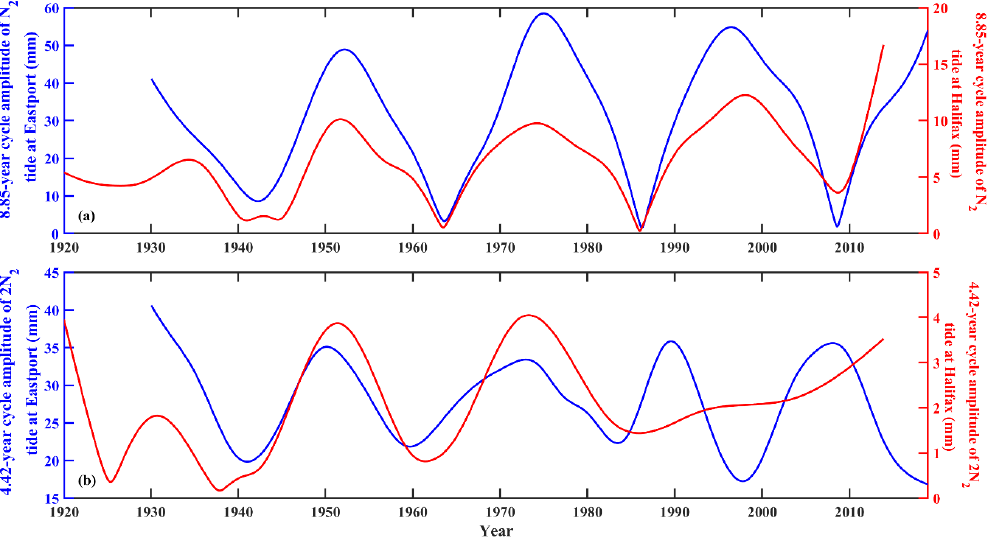
Figure 7. The 8.85-year cycle amplitudes of N 2 tide ( a ) and 4.42-year cycle amplitudes of 2N 2 tide ( b ) at Eastport (blue lines) and Halifax (red lines).